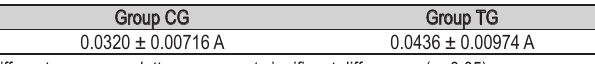
Different upper case letters represent significant differences